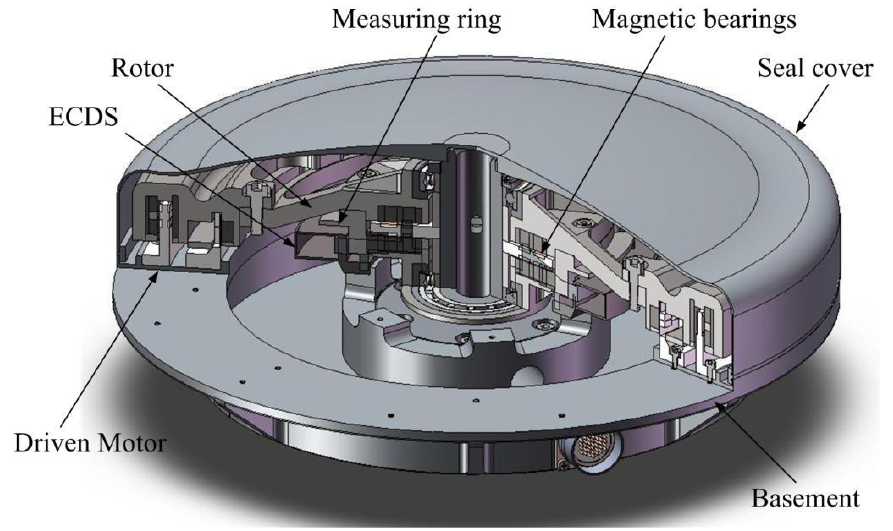
Figure 1. The sketch of the MSFW whose rotor is suspended by the magnetic bearings and monitored by the multi-channel